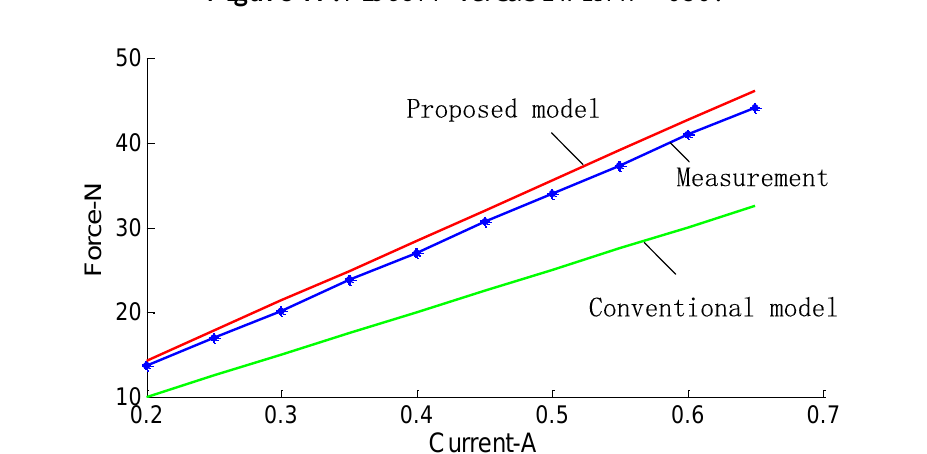
Figure 17. Plot of F versus I with n =